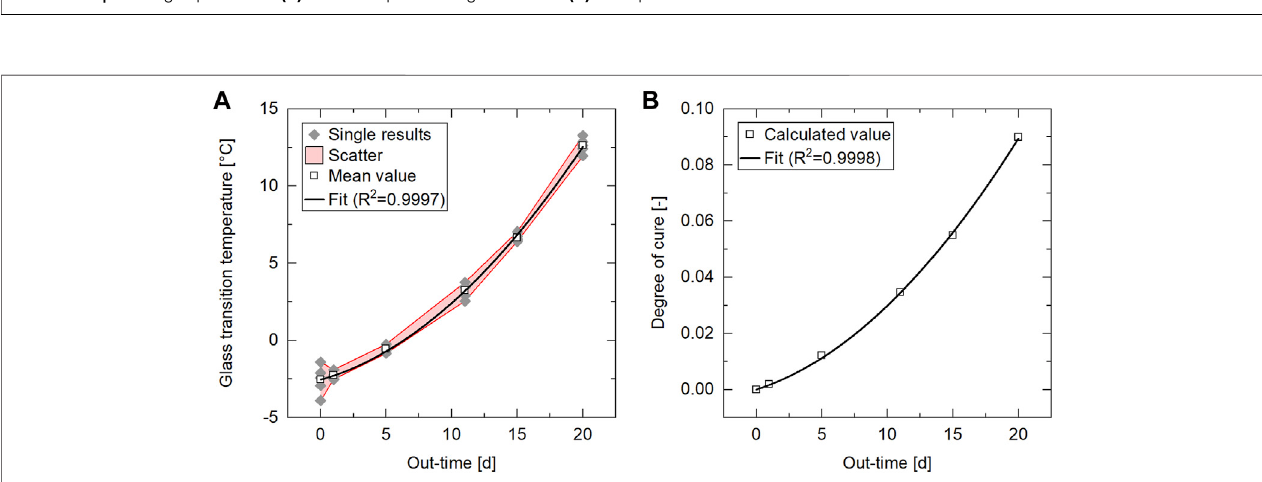
FIGURE 5 | Steering experiments. (A) Steered tapes and digital camera. (B) Pull-up and buckles.